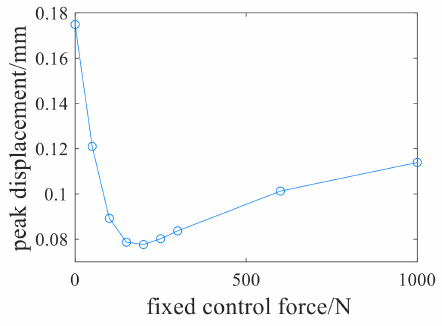
Figure 22. Relationship between peak displacement of measurement point and fixed control force.